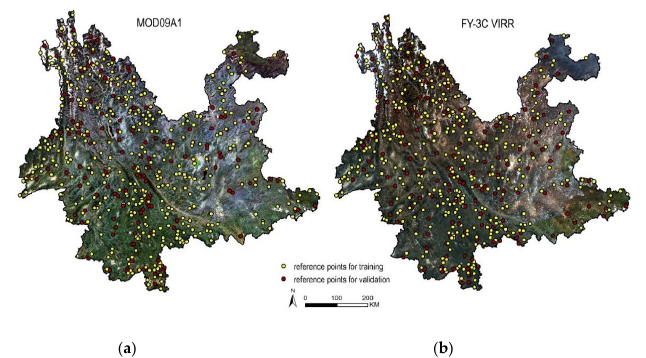
Figure A1. The true-color MOD09A1 ( a ) and FY-3C VIRR ( b ) imageries of Yunnan Province, with the dots showing the sampling points to estimate forest AGB.